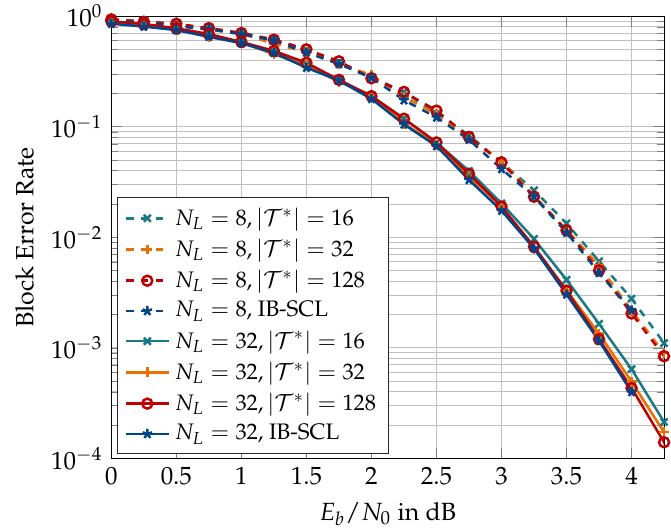
Figure 24. Effect of alignment cardinality |T ∗ | on the block error rate of a 4-bit aligned information bottleneck SCL decoder with N L = 8 or 32, 16-bit CRC for N = 128, rate 0.5, and design E b / N 0 = 3 dB.